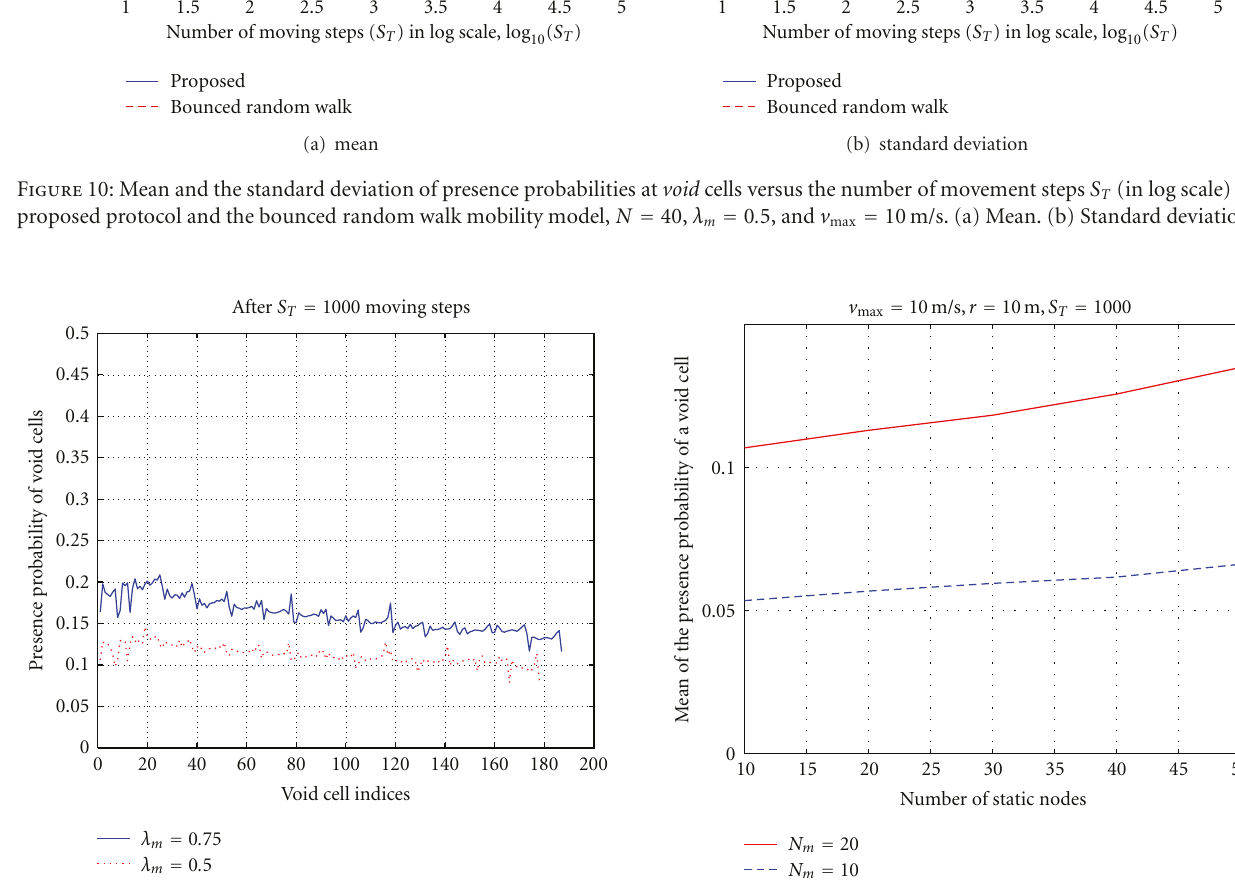
Figure 12: Mean of the presence probabilities of void cells when the number of static nodes varies; v max = 10m/s, S T =